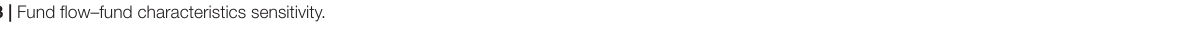
Table 2 is the result of comparing the fund flow–performance sensitivity. The dependent variable is fund flow, Raw return is the average of returns over the previous 12 months; MKT-Adj return, the market-adjusted returns over the previous 12 months; CAPM-Adj return, CAPM-adjusted return over the previous 12 months. The content of the table is the regression coefficient value; the figure in parentheses, t-value; and ***, **, and * means that each is significant, respectively, at 1, 5, and 10%. TABLE 3 | Fund flow–fund characteristics sensitivity. CL.